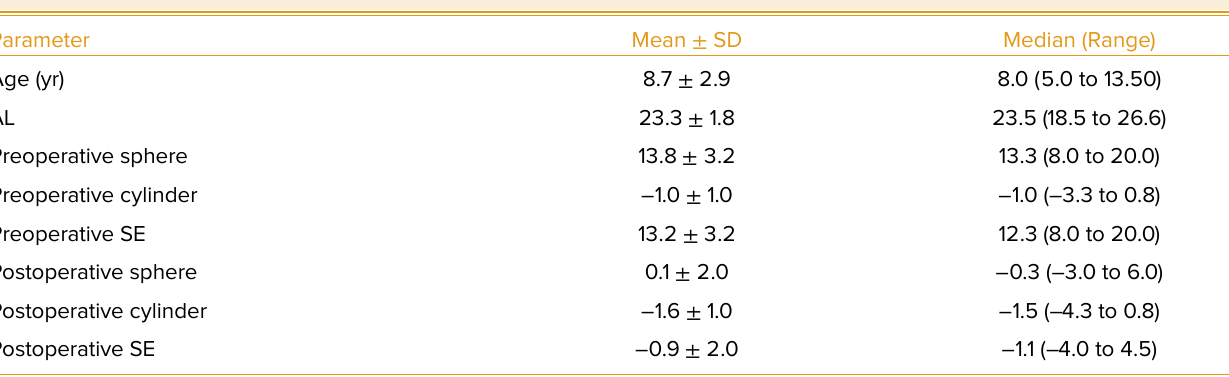
Table 1. Baseline characteristics of study participants.